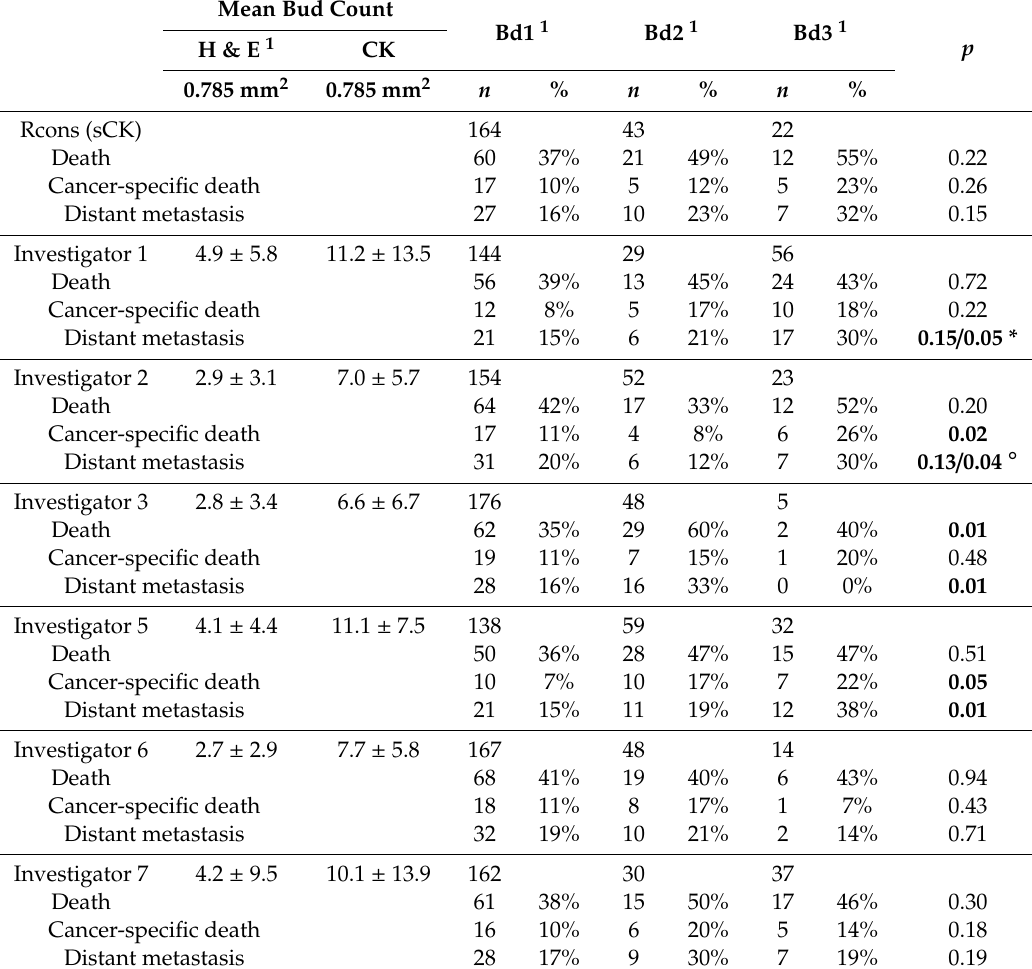
Table 2. Overview of the rating results in terms of the prognostic